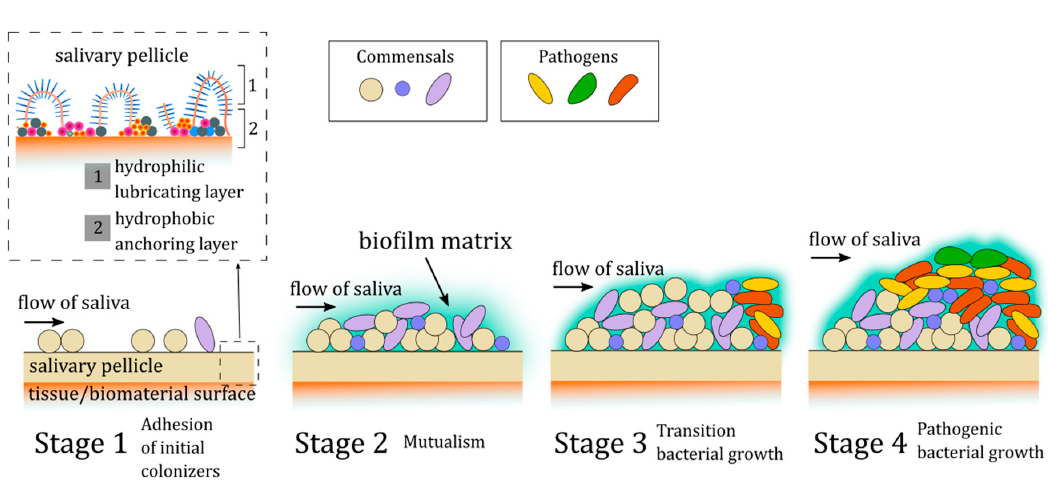
Figure 4. Diagram of adhesion and biofilm growth (based on [108]).